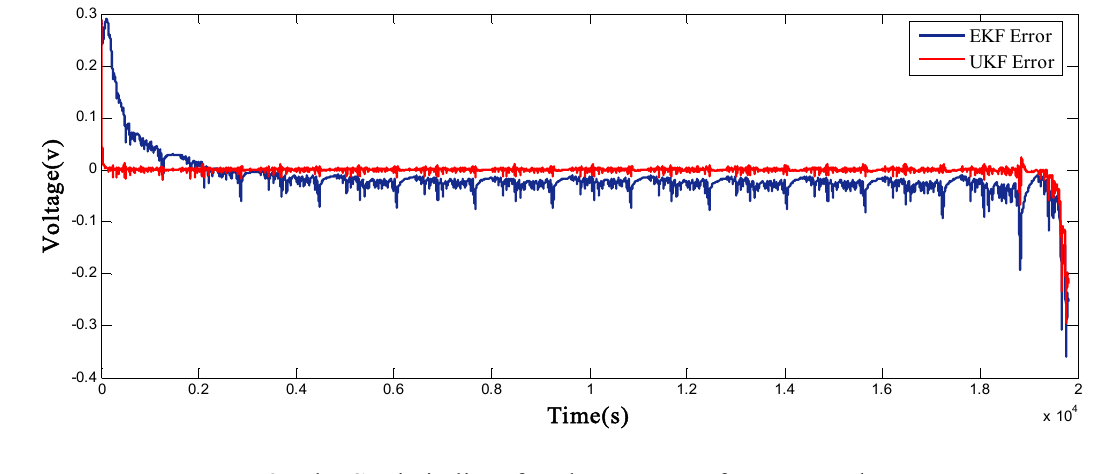
Table 2. The Statistic list of Voltage Errors for EKF and